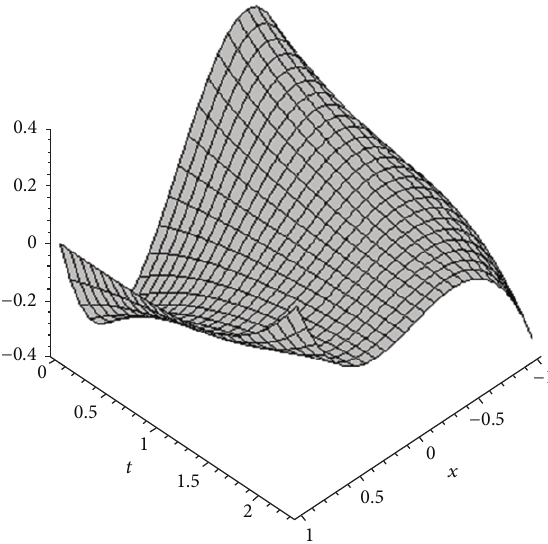
Figure 2: The graphic of the function 𝑢 ∗ 1 (𝑡,𝑥) in the test problem (32).